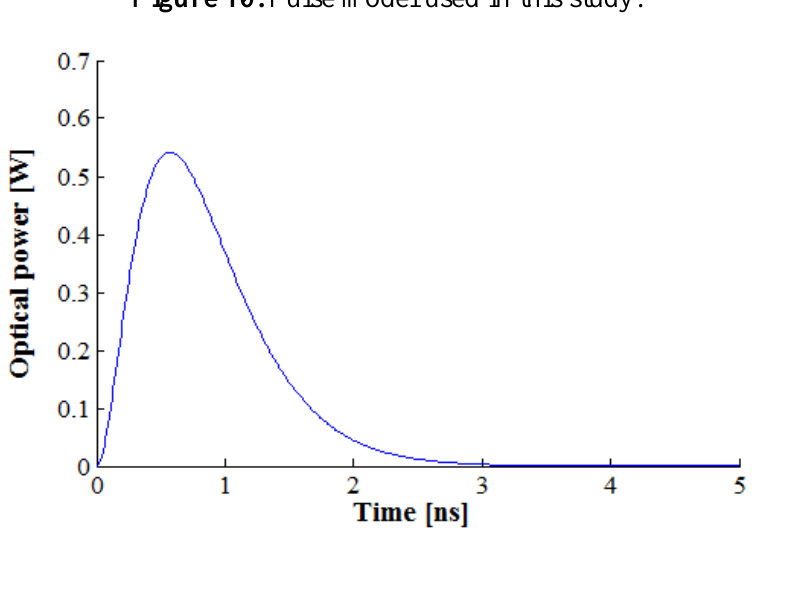
Figure 10. Pulse model used in this